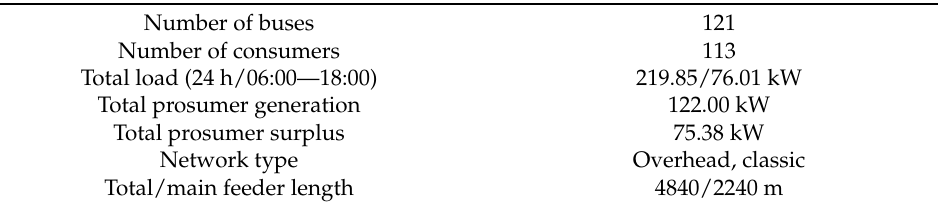
Figure 4. The EDN used in the study. Table 1. Summary data for the network used in the case